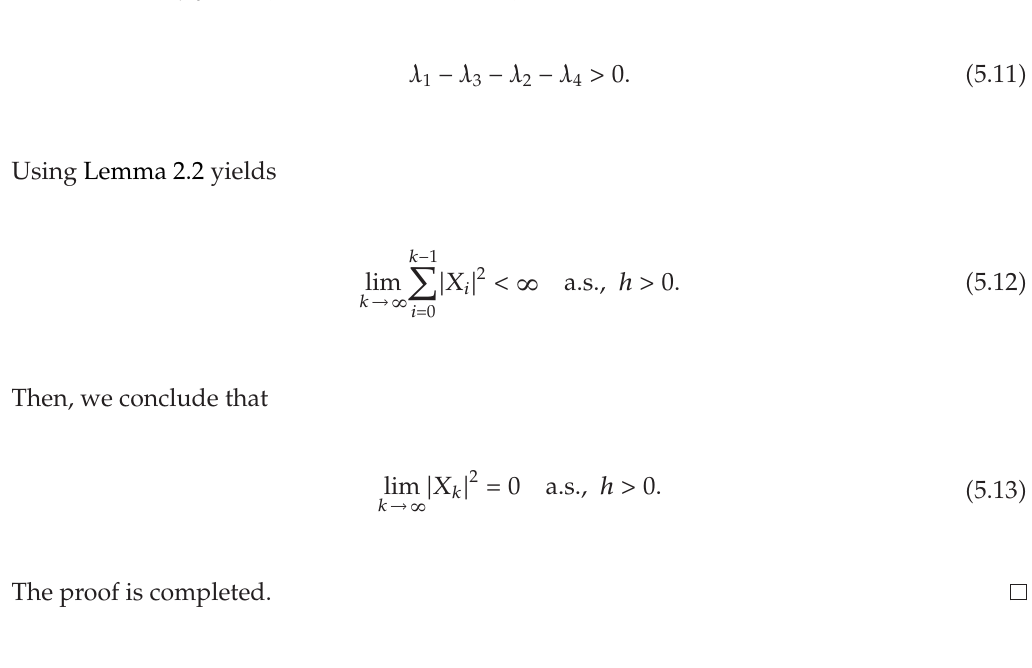
λ 1 − λ 3 − λ 2 − λ 4 > 0 . (cid:3) 5.11